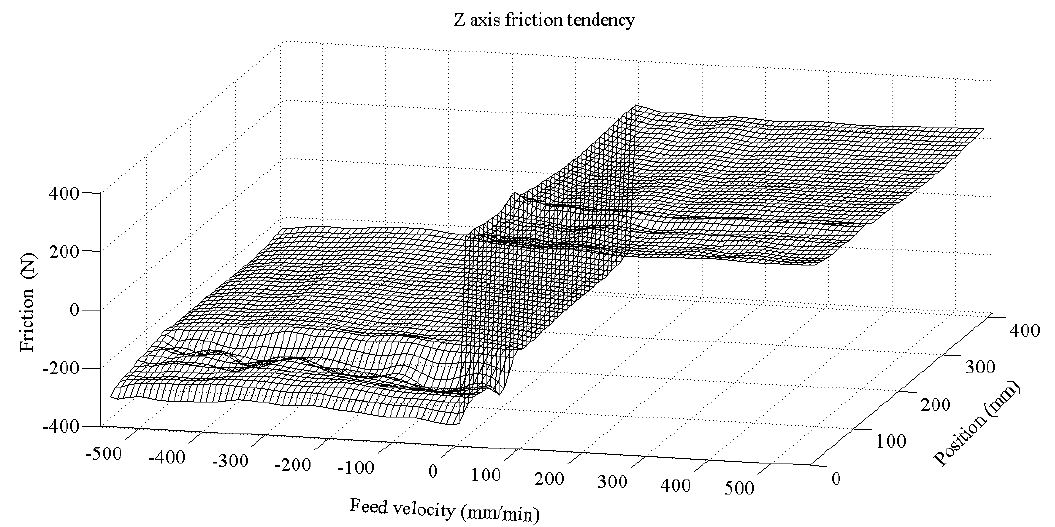
Figure 13. Variations in the MVOIAF with WP and the feed velocity. Table 3. Position corresponding to the symbols a-a to f-f in Figure 12.